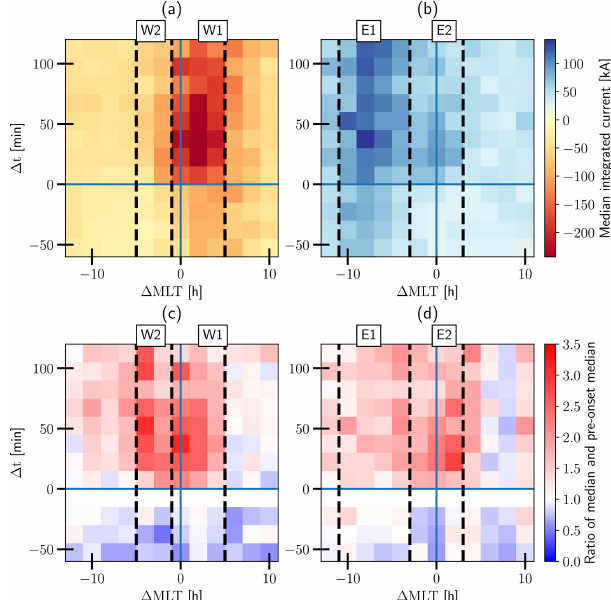
Figure 4. The development of the median integrated westward (a) and eastward (b) current binned with 15min bins with respect to the temporal difference from the substorm onset and with a 2h bin with respect to the MLT difference from the onset. Panels (c) and (d) show the ratio of the medians in panels (a) and (b) compared with the value just before the onset. The dashed vertical lines show the extent of sectors W1, W2, E1 and